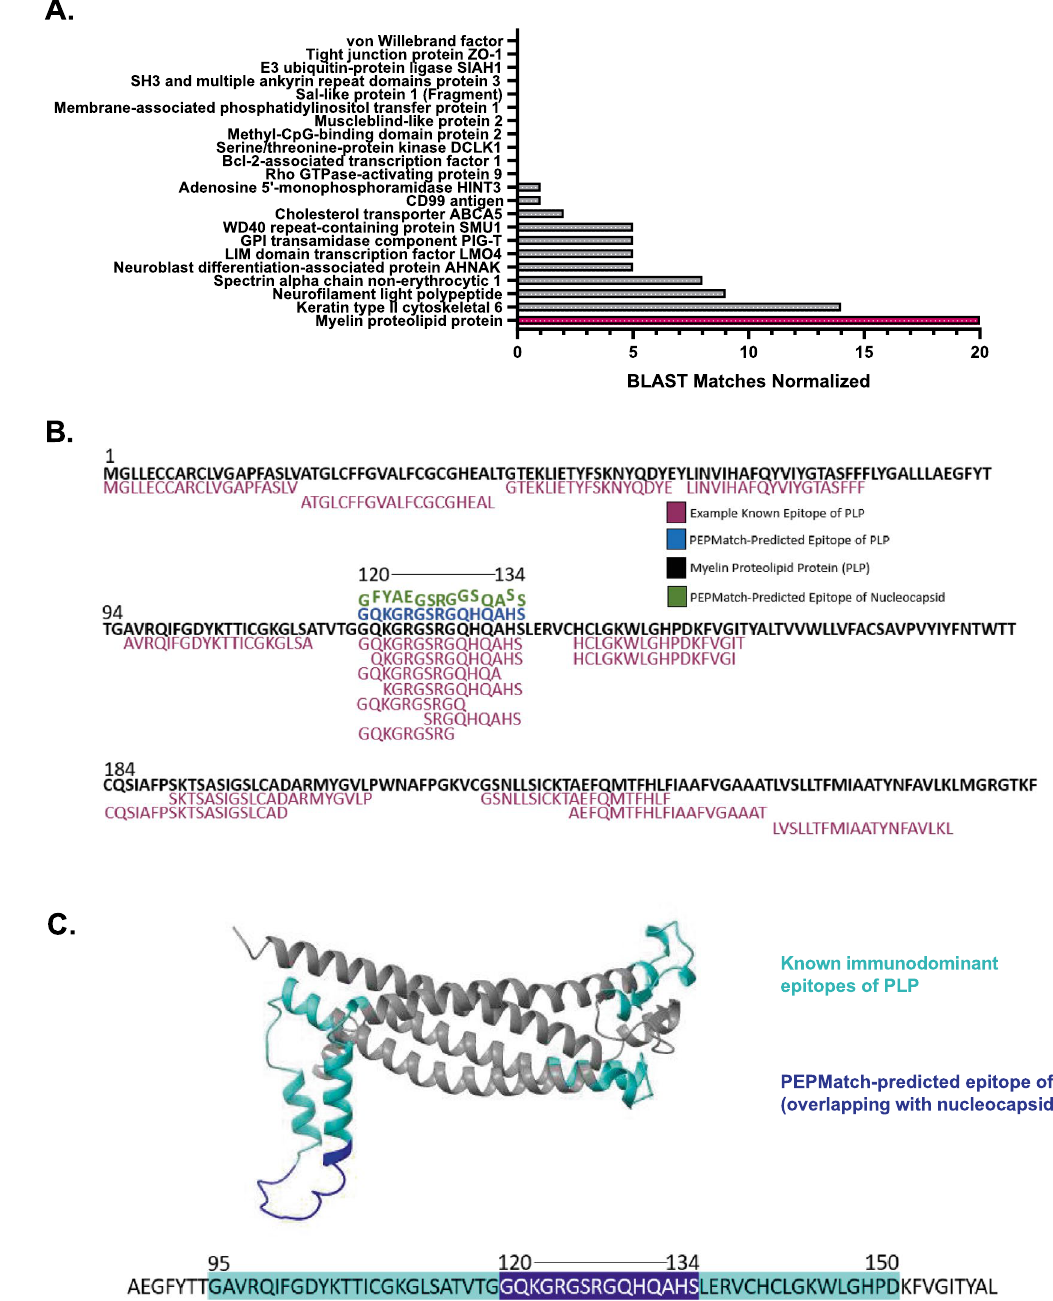
Figure 2. PEPMatch-predicted epitope of myelin proteolipid protein (PLP) has high similarity to experimentally validated epitopes and is in a region associated with strong T cell responses in MS patients. ( A ) PEPMatch- predicted peptides sharing homology with nucleocapsid were assessed for overlap with known, experimentally validated epitopes on the Immune Epitope Databases (IEDB). All known epitopes for each protein were run in a BLASTp query against the peptide(s) returned from PEPMatch. The number of homology “hits” were quantified and divided by the number of input PEPMatch peptides for that protein for normalization. ( B ) The PEPMatch- predicted epitope of PLP matching nucleocapsid (blue) was aligned with the full-length sequence of PLP (black) and the nucleocapsid peptide to which it matches (green) alongside examples of known epitopes of PLP identified in the literature and available on the IEDB (berry). ( C ) Predicted PLP structure was highlighted with known immunodominant areas previously identified as eliciting strong T cell responses preferentially in MS patients 20 (cyan) against the PEPMatch-predicted epitope sharing homology with nucleocapsid (dark